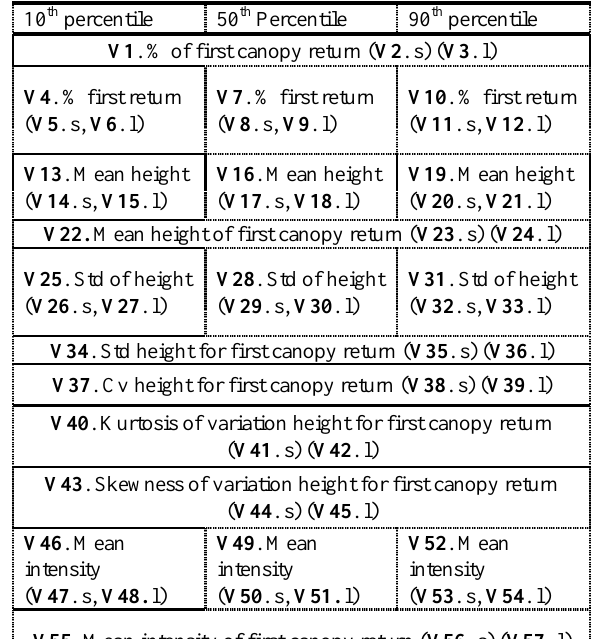
numbers are in bold.